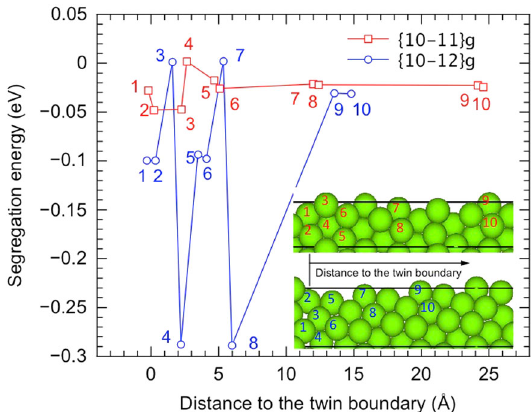
Fig. 4 Segregation energies of yttrium atom in the vicinity of TBs of f 1011 g and f 1012 g . The initial solute sites in f 1011 gh 1012 i twin are in red , while in the other twin are in blue in the inset. To differentiate twins of glide from re fl ection variants, subscript “ g ” is used to represent the glide twin. When one yttrium atom is introduced into the glide variants of TBs (sites 1-10), transformations from glide to re fl ection TBs are observed in the simulations. In the case of f 1011 gh 1012 i twins, regardless of the segregation sites of yttrium, the glide TB always transforms to the re fl ection variant. The